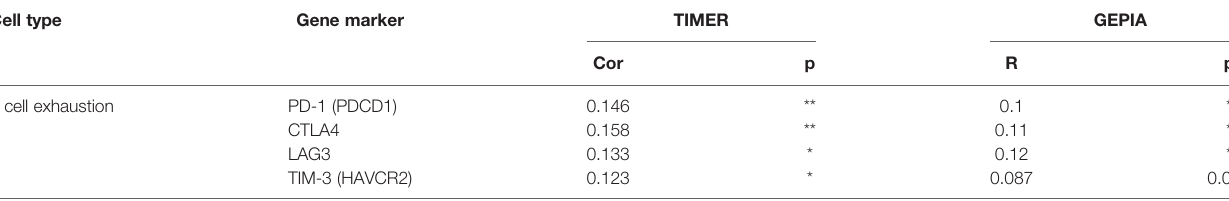
TABLE 3 | Spearman correlation analysis between LAGE3 and markers of T cell exhaustion in patients with HCC by TIMER and GEPIA. Cell